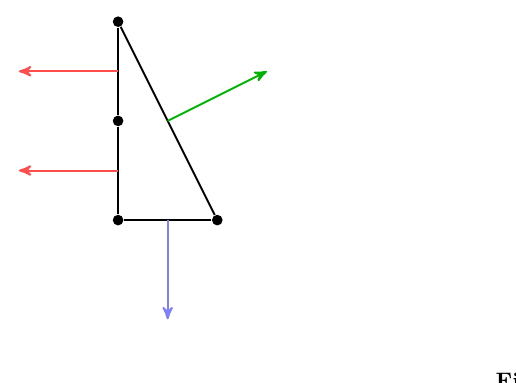
Figure 2a. The toric diagram of C 2 / Z 2 × C and the vectors orthogonal to the edges.